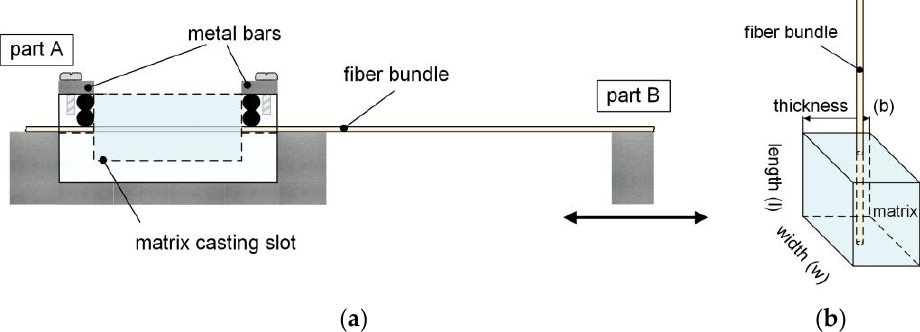
Figure 1. Schematic illustration of the working principle of the manufacturing tool with the main components ( a ) and fiber bundle pull-out (FBPO) specimen ( b ) [35].